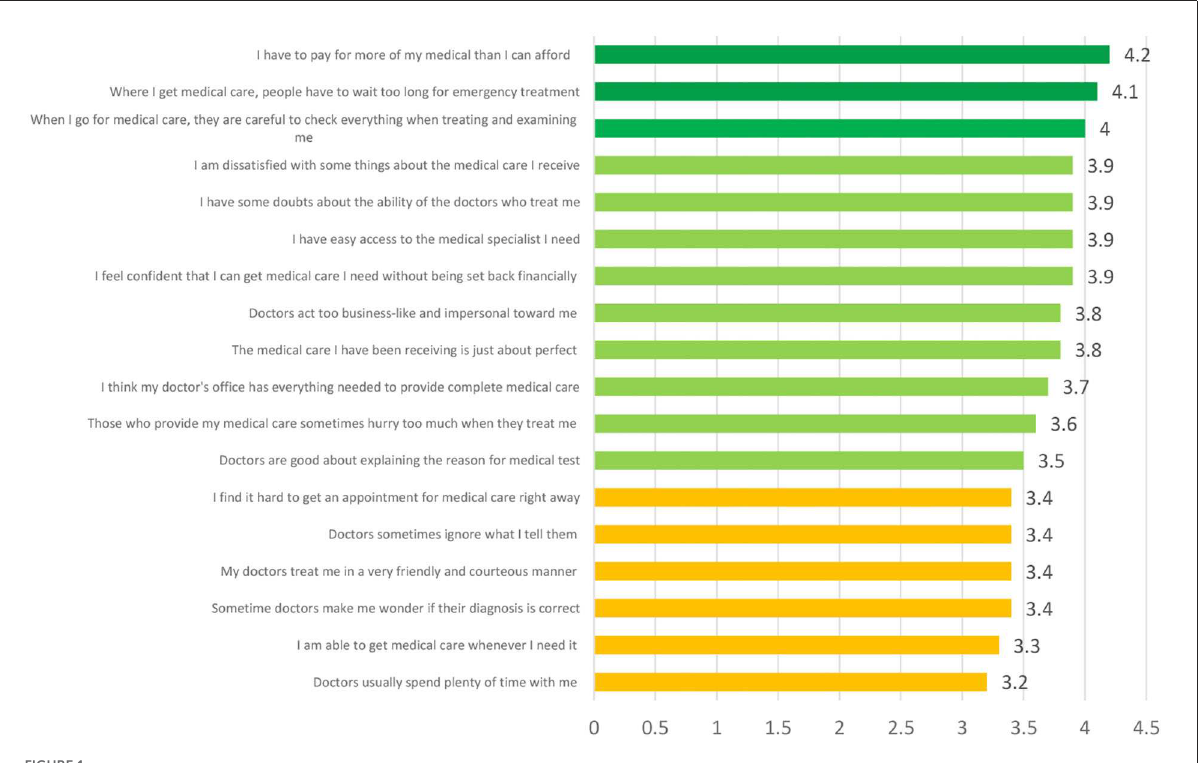
FIGURE1 Comparison of scores given by participants of the study on PSQ-18 items.